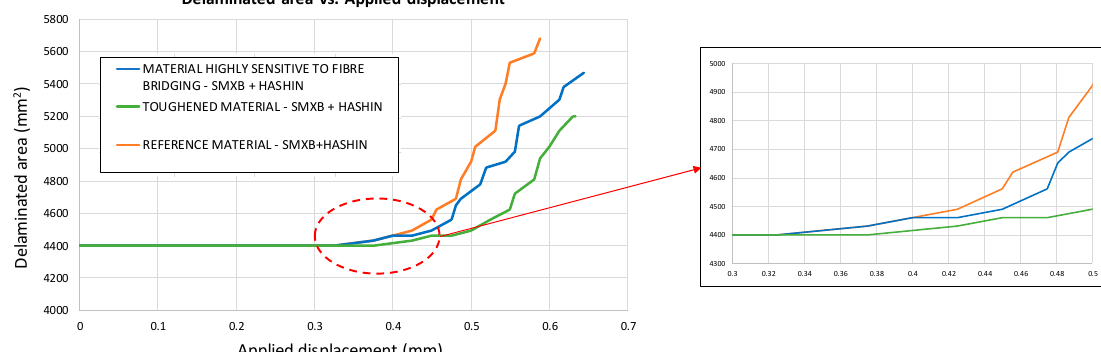
Figure 19. Delaminated area vs. Applied displacement (SMXB+HASHIN).